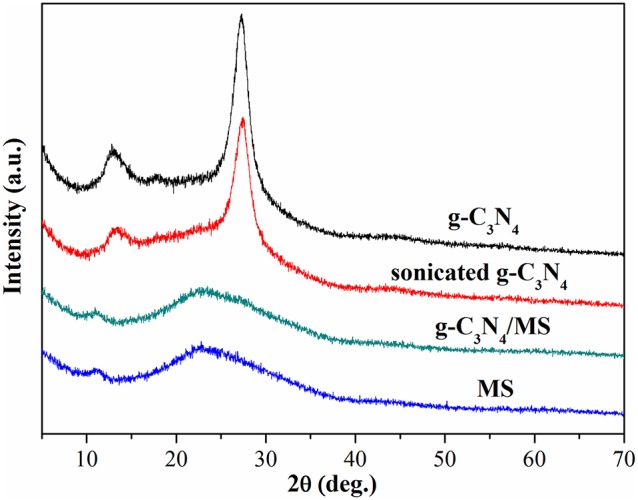
PXRD patterns of g-C3N4, sonicated g-C3N4, g-C3N4/MS and MS.